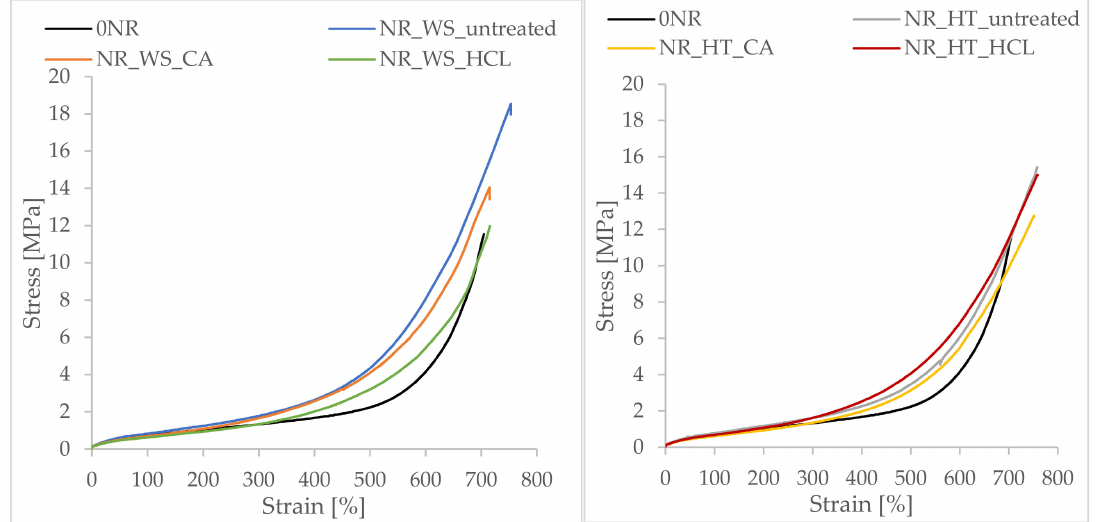
Figure 11. Stress–strain curves of vulcanizates filled with biofiller.